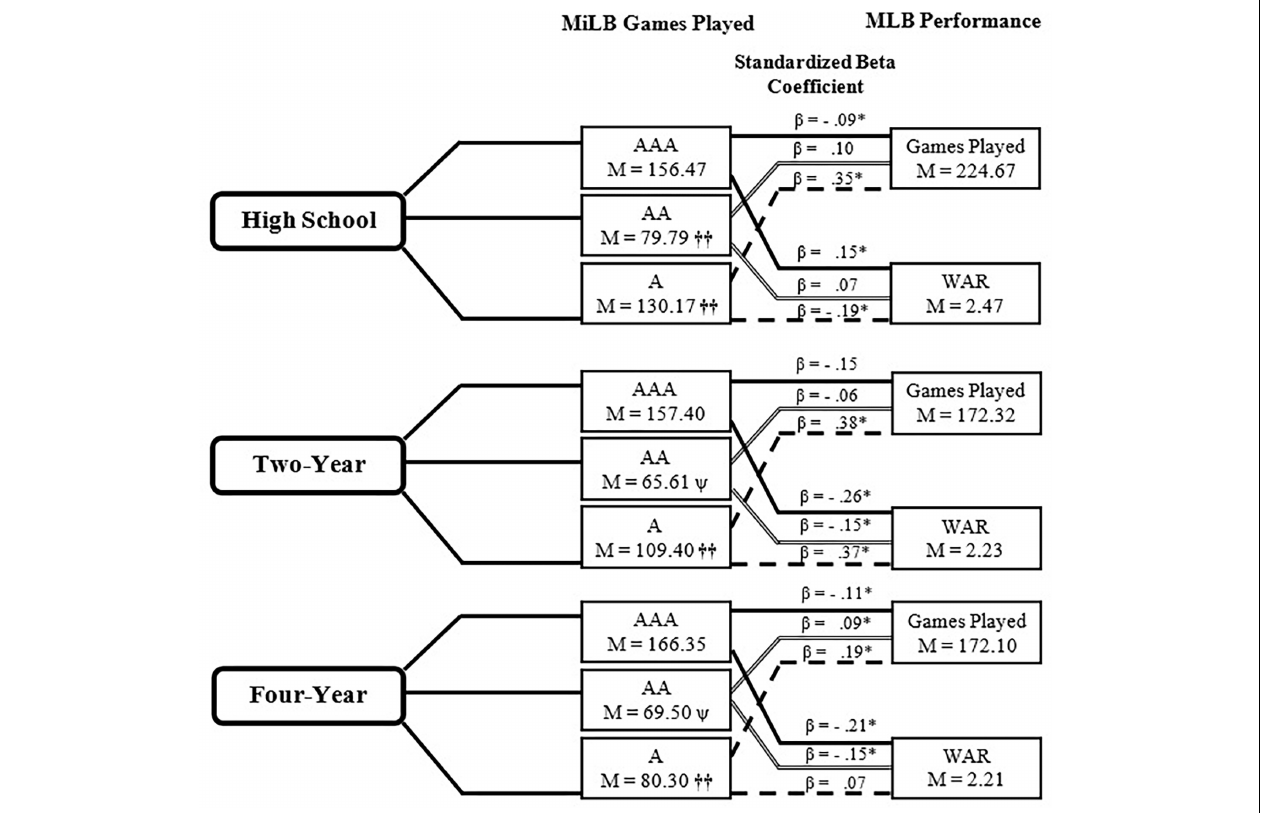
FIGURE 3 | Relationship between Minor League career and MLB performance- Pitchers. WAR, Wins Above Replacement, †† Significant difference ( p < 0.05) from two other institutions at that level. (cid:57) Significant difference ( p < 0.05) from High School institution at that level. β Signifies standardized beta coefficient from regression model with A, AA, AAA Games Played used as predictors of Major League Baseball Games Played and Wins Above Replacement; ∗ p <